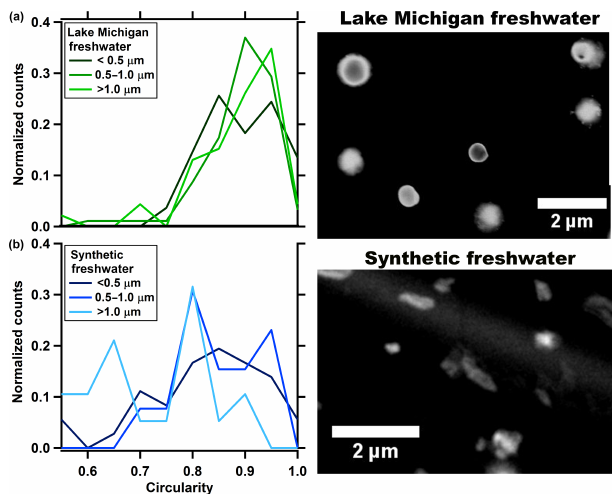
Figure 6. Circularity of (a) Lake Michigan freshwater particle sam- ple and (b) synthetic freshwater particles as a function of diameter from the LSA generator, as well as example SEM images of the impacted particles used in the analysis. Table 2. Fresh- and seawater droplet diameters ( d d ) calculated from the mass (assuming particle density is 1.2gmL − 1 ) of the dominant dry particle diameter ( d 0 ) modes produced from synthetic seawater (SSA) and the Lake Michigan freshwater sample